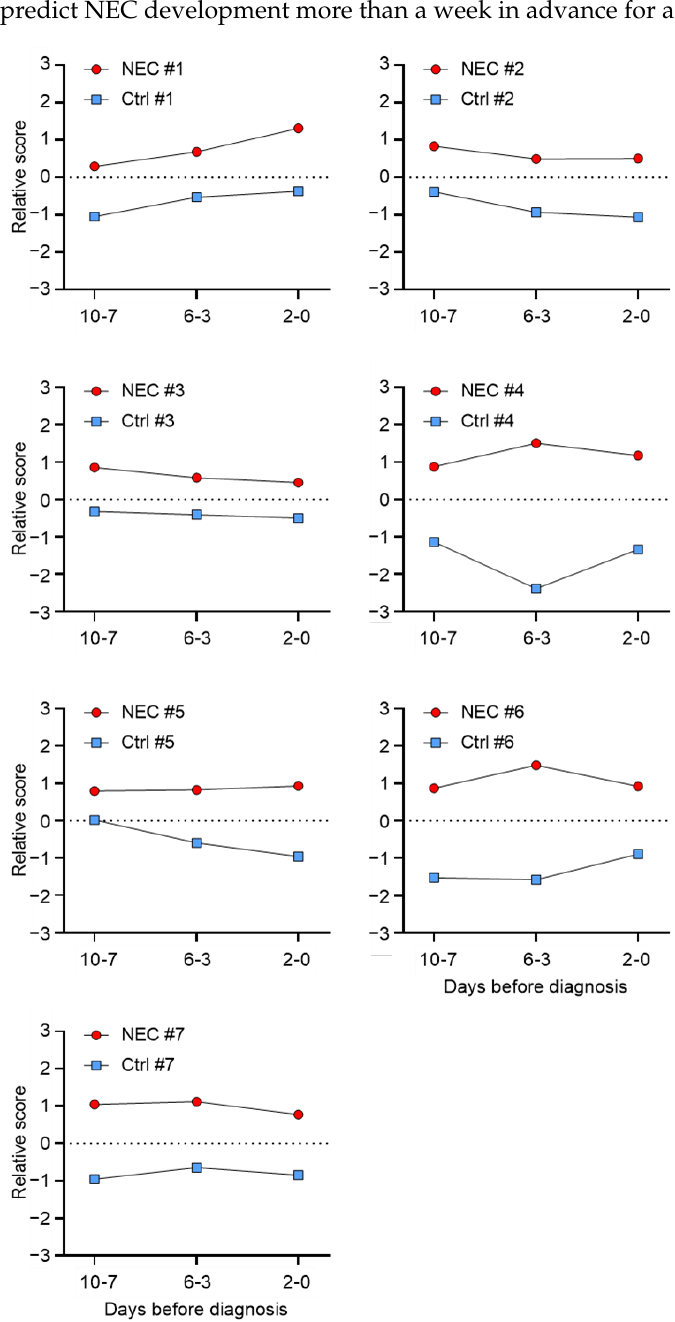
Figure 8. Relative score according to paired samples. Plots of the relative score (Y-axis) of the 36 protein marker levels across the three tested periods (X-axis: 10-7, 6-3, 2-0 days before NEC diagnosis) for each of the 21 paired NEC (red dot) and non-NEC control (blue square) samples from the seven paired cases. The two-tailed paired t test on the 36 protein markers (increased and decreased; multiply by − 1) gave a significant difference of at least p ≤ 0.05 for all the pairs of the samples.